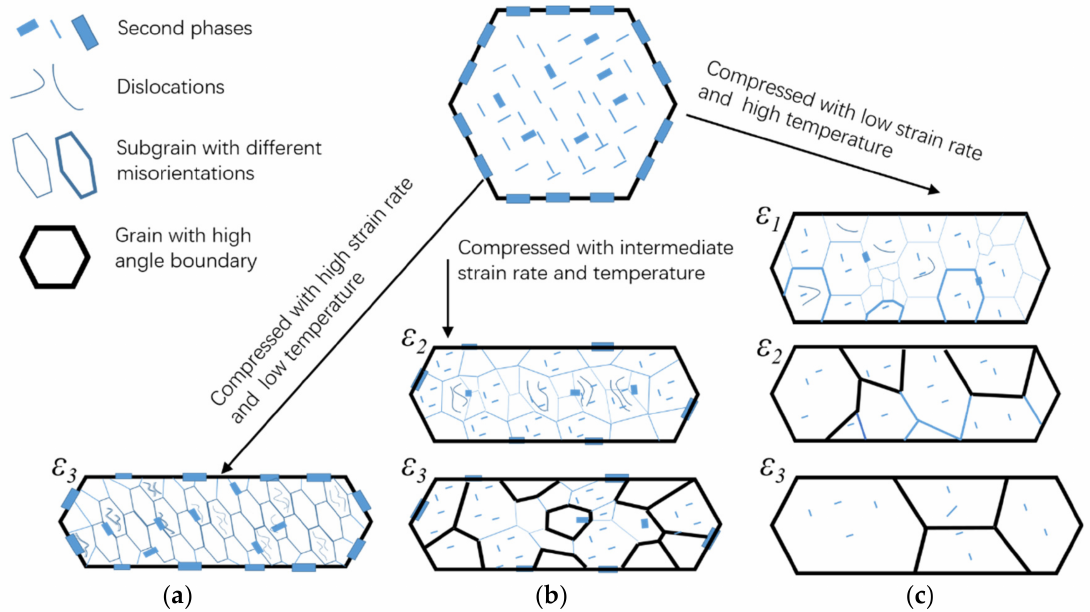
Figure 12. Diagrammatic sketch of the microstructure evolution of spray-deposited 7055 aluminum alloy. ( a ) Dynamic recovery and a few second phases resolve. ( b ) Dynamic recrystallization based on the “subgrain rotation”, “subgrain boundary migration” and “PSN” nucleated mechanism. ( c ) Dynamic recrystallization based on “homogeneous misorientation increase of subgrain”, and a few phases